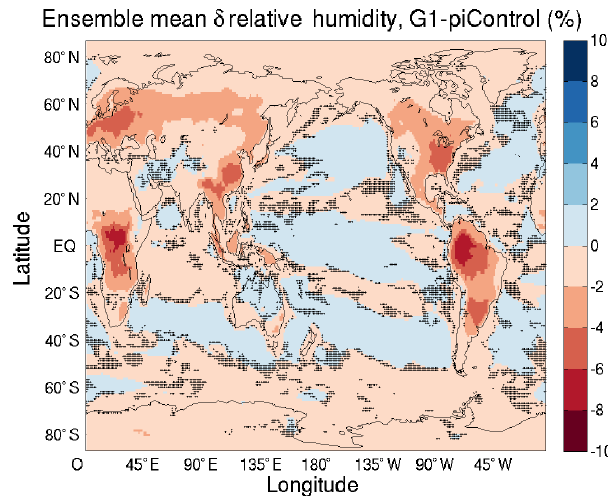
Figure 5. The annual mean near-surface relative humidity anomaly between G1 (years 11–50) and piControl (all years) in eight GCMs. The stippling indicates that fewer than 62.5% of the models agree on the sign of the change (data unavailable for HadC, CESM, and MPI models; EC-Earth